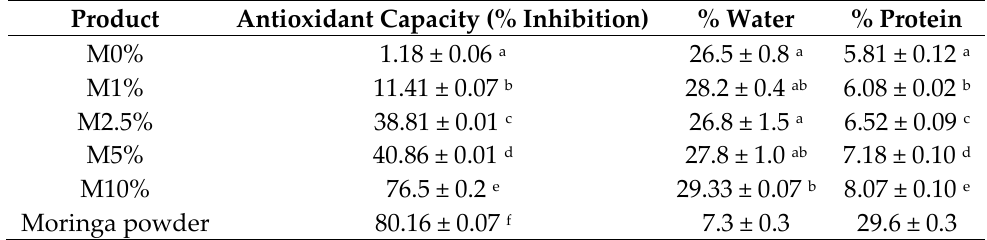
Table 1. Percentages of water, protein and DPPH inhibition in cupcakes (M) depending on